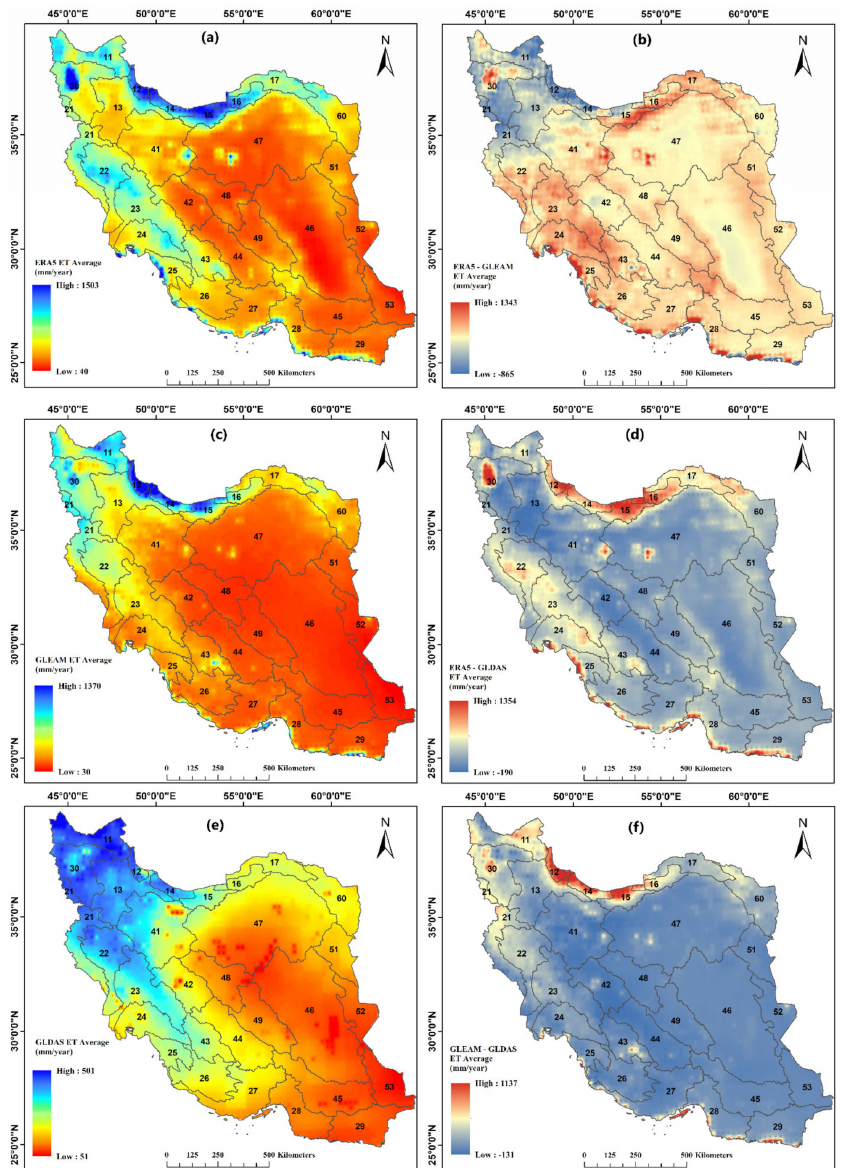
Figure 2. Long term annual average (1980–2018) evapotranspiration (ET; mm/yr) and the long- term annual average difference between datasets over Iran according to ( a ) the average of ET ERA5 , ( b ) ET ERA5 -ET GLDAS , ( c ) the average of ET GLEAM , ( d ) ET ERA5 -ET GLDAS , ( e ) the average of ET GLDAS , and ( f ) ET GLEAM -ET GLDAS